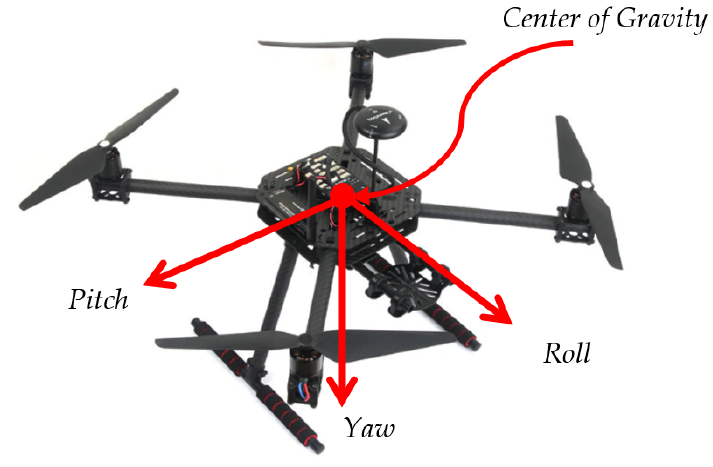
Figure 7. Axes about which the moments of inertia were to be determined.